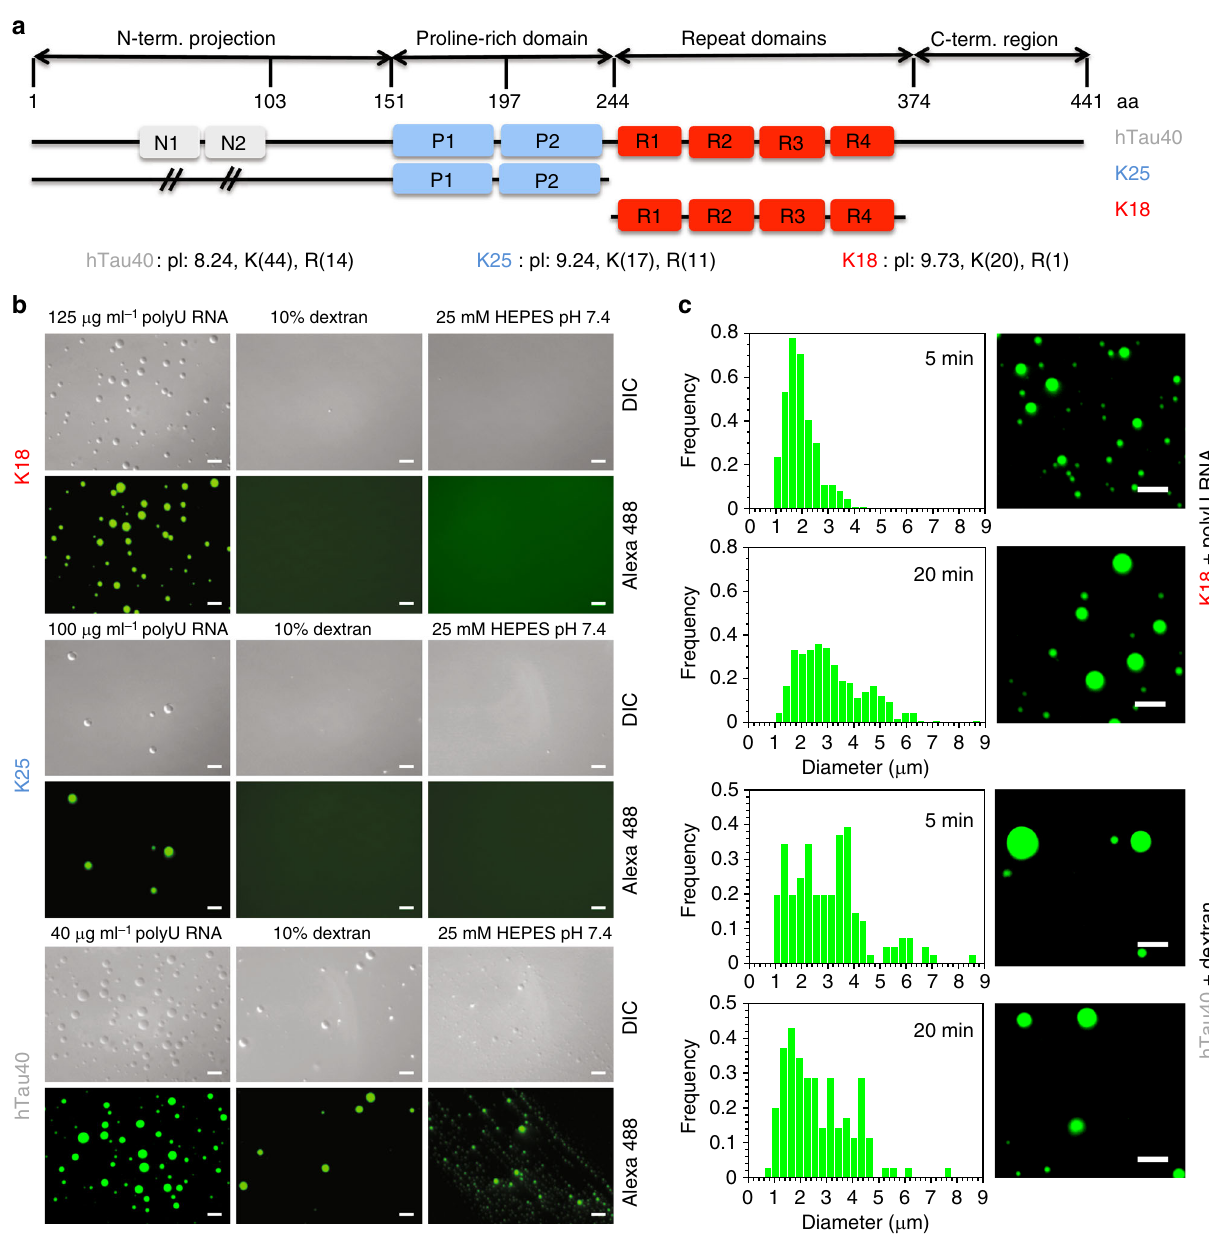
Fig. 4 In fl uence of tau domain structure and co-factors on LLPS. a Domain organization of hTau40, K25, and K18. N1 and N2 are the two inserts not present in K25, P1, and P2 the two proline-rich regions, and R1 – R4 the four pseudo-repeats. The pI and the number of lysine (K) and arginine (R) residues in hTau40, K25 and K18 are indicated. b DIC and fl uorescence micrographs of hTau40, K25, and K18 solutions in the presence of different co-factors/buffer conditions. The concentration of the proteins was 50 μ M. c Droplet size distribution of K18 (top) and hTau40 (bottom) after fi ve and 20 min alongside corresponding fl uorescence images. K18 (50 μ M) with 125 µ g ml − 1 polyU RNA in 25 mM HEPES, pH 7.4, was used. For hTau40 (50 μ M), the same buffer was used with 10% dextran (and no RNA). Scale bar, 10 μ Acetylation reduces co-localization of tau with stress granules . were added and after extensive washing, SGs were visualized by in vivo 38,41,51,52 . To investigate the importance of lysine for co- localization of tau with SGs, we analyzed different tau sequences and acetylated tau for their binding to SGs in semi-permeabilized (Fig. 8b – d). In addition, all three tau constructs (hTau40, K25 and Hela cells 18 (see schematic in Fig. 8a). Here, SGs were induced by K18) co-localized with SGs, but to a different extent (Fig. 8b). the proteasome inhibitor MG132 and the plasma membrane of cells was subsequently selectively permeabilized by digitonin. with SGs (Fig. 8c and Supplementary Fig. 8a). K18 and hTau40 Soluble cytosolic factors were washed out and nuclear pore complexes blocked with wheat germ agglutinin (WGA). Next, equal amounts of recombinant, fl uorescently labeled tau proteins